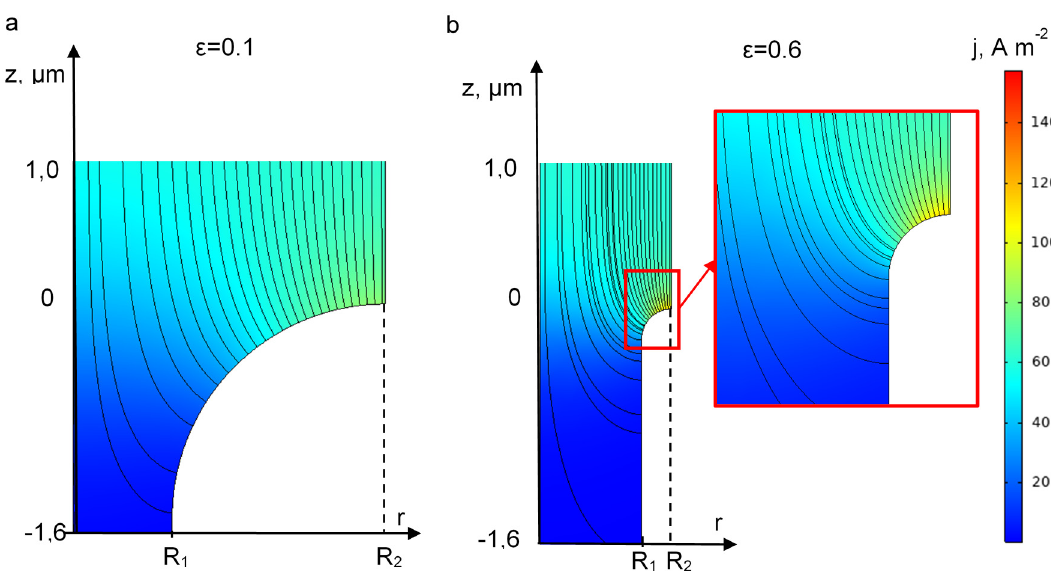
Figure 8. The influence of the REM porosity (mentioned in the pictures) on the local current density distributions at j = 60 A · m − 2 and ε = 0.1 ( a ) and 0.6 ( b ). All other parameters are presented in Table 1.